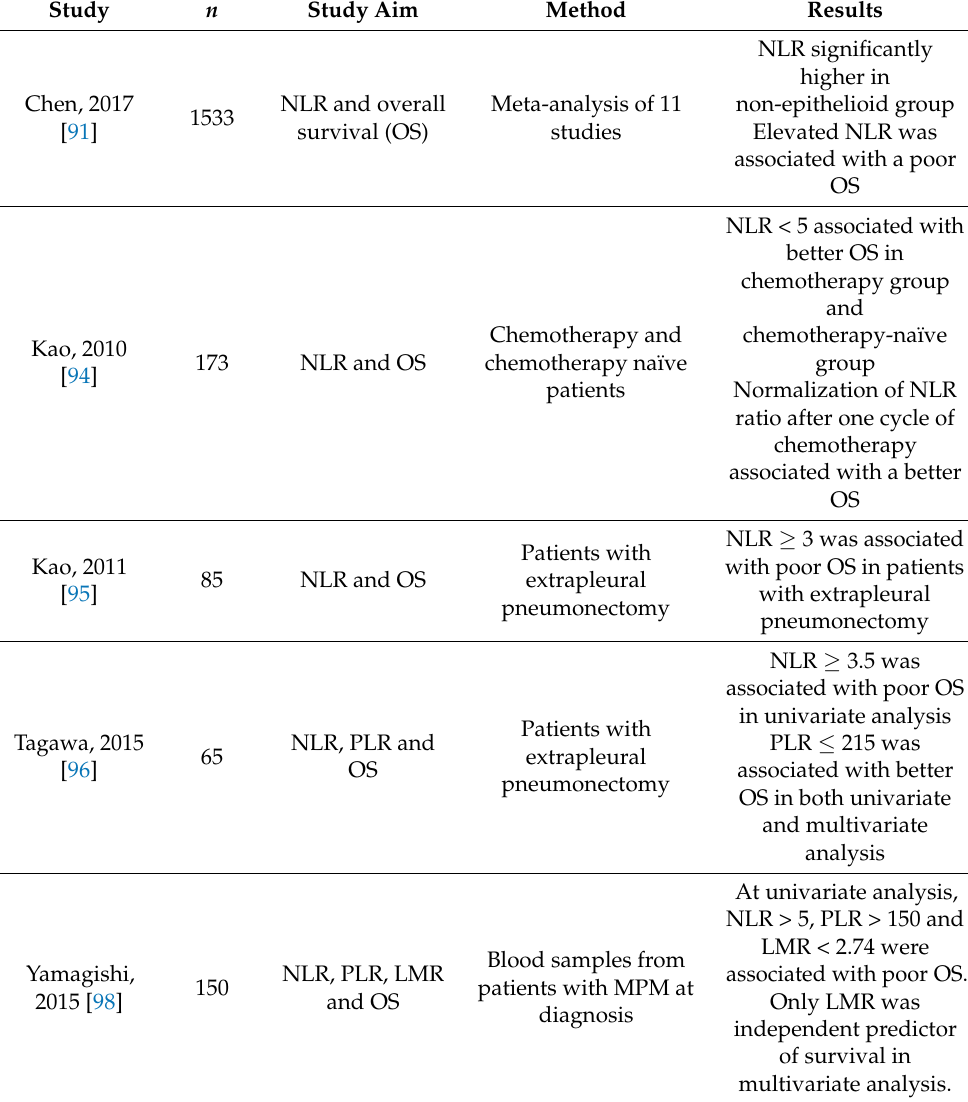
Table 3. Studies with neutrophil-to-lymphocyte ratio (NLR), platelet-to-lymphocyte ratio (PLR) and lymphocyte-to-monocyte ratio (LMR) as potential prognostic biomarkers in malignant pleural mesothelioma